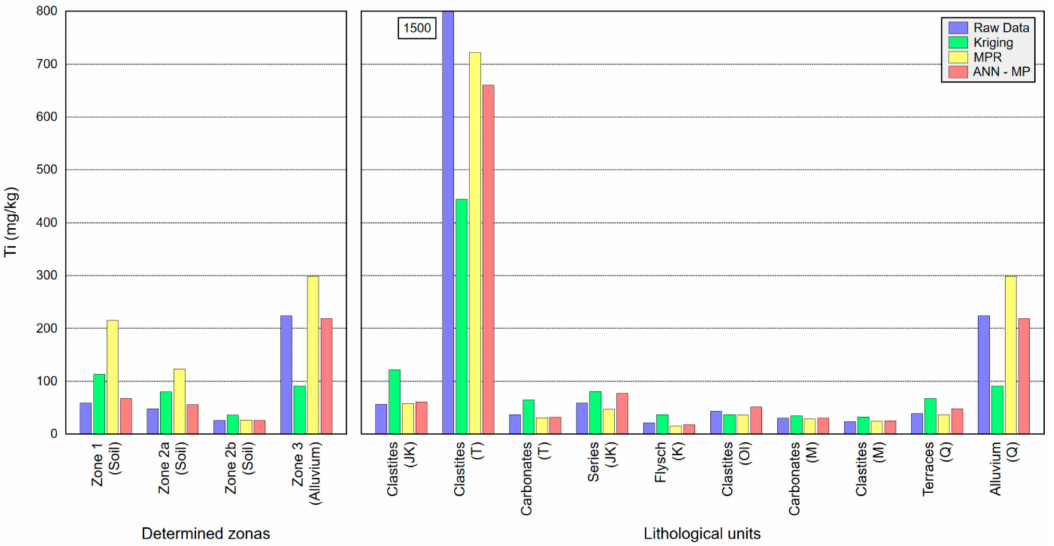
Figure A2. Distribution of predicted values of Titanium in isolated lithological units according to raw data and prediction methods after using the Box-Cox